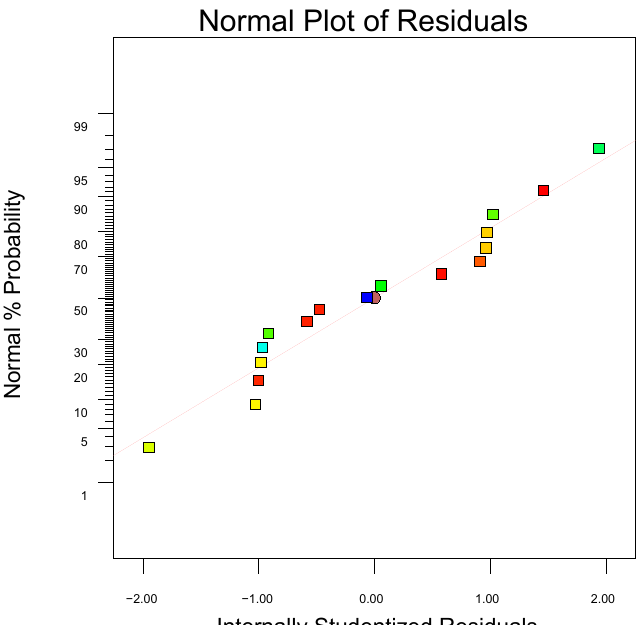
Figure 3. Normal plot of residuals. Combined with the above regression model, the response surface map and contour map of the model were drawn by Design − Expert, from which the influence of the inter- action of various factors on AST@PLGA drug loading can be analyzed. The results are shown in Figure 4. The steepness of the curve in the 3D response surface map, the density of contours, and the degree of color change in the contour map may reflect the influence of the interaction of the two variables on the DL [32]. The greater steepness of the curve, the denser contours, and the faster color change indicate greater influence on the DL. As shown in Figure 4, the curves of Figure 4a,b are steep, and the steepness of Figure 4c is lower than that of the two former figures. In combination with Table 7, the interaction between AC and AB was extremely significant, whereas the interaction of BC was less than that of the two former combinations. The predicted optimal prescription is an 11.205 drug − to − carrier ratio, 13.079 water − to − oil ratio, and 1.5 min ultrasound time. The predicted DL is 6.824%.